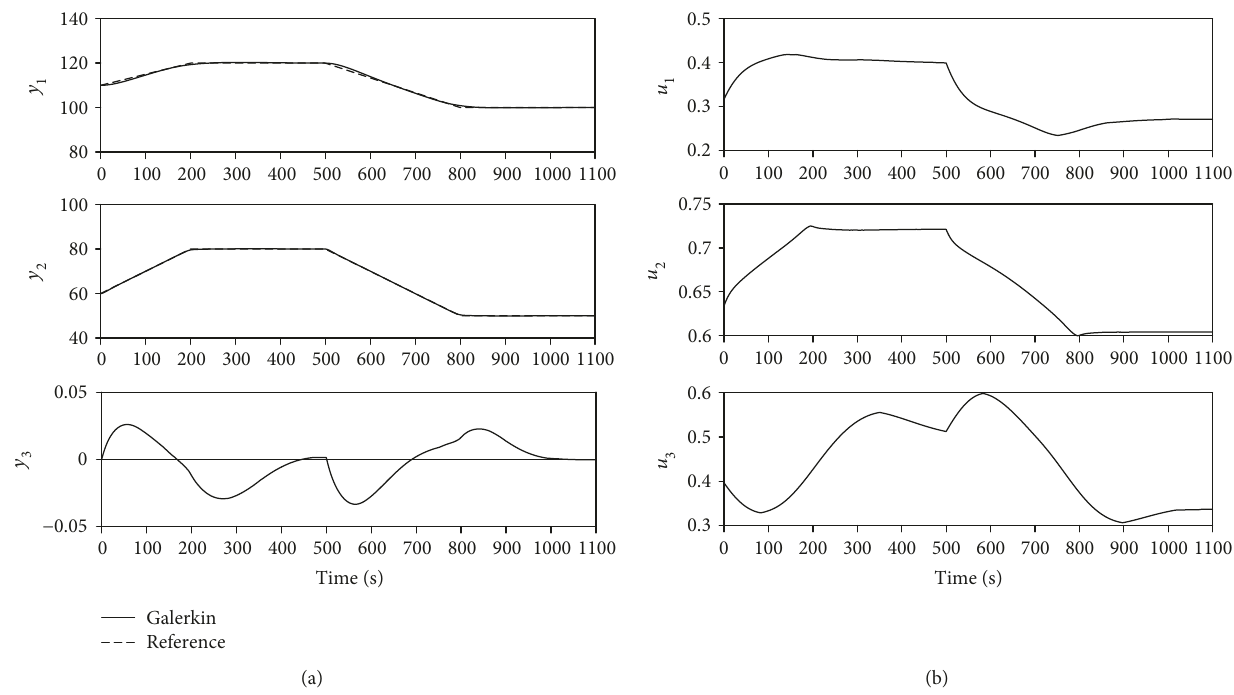
Figure 9: Outputs and controls of the unit in the case of tracking large-scale load